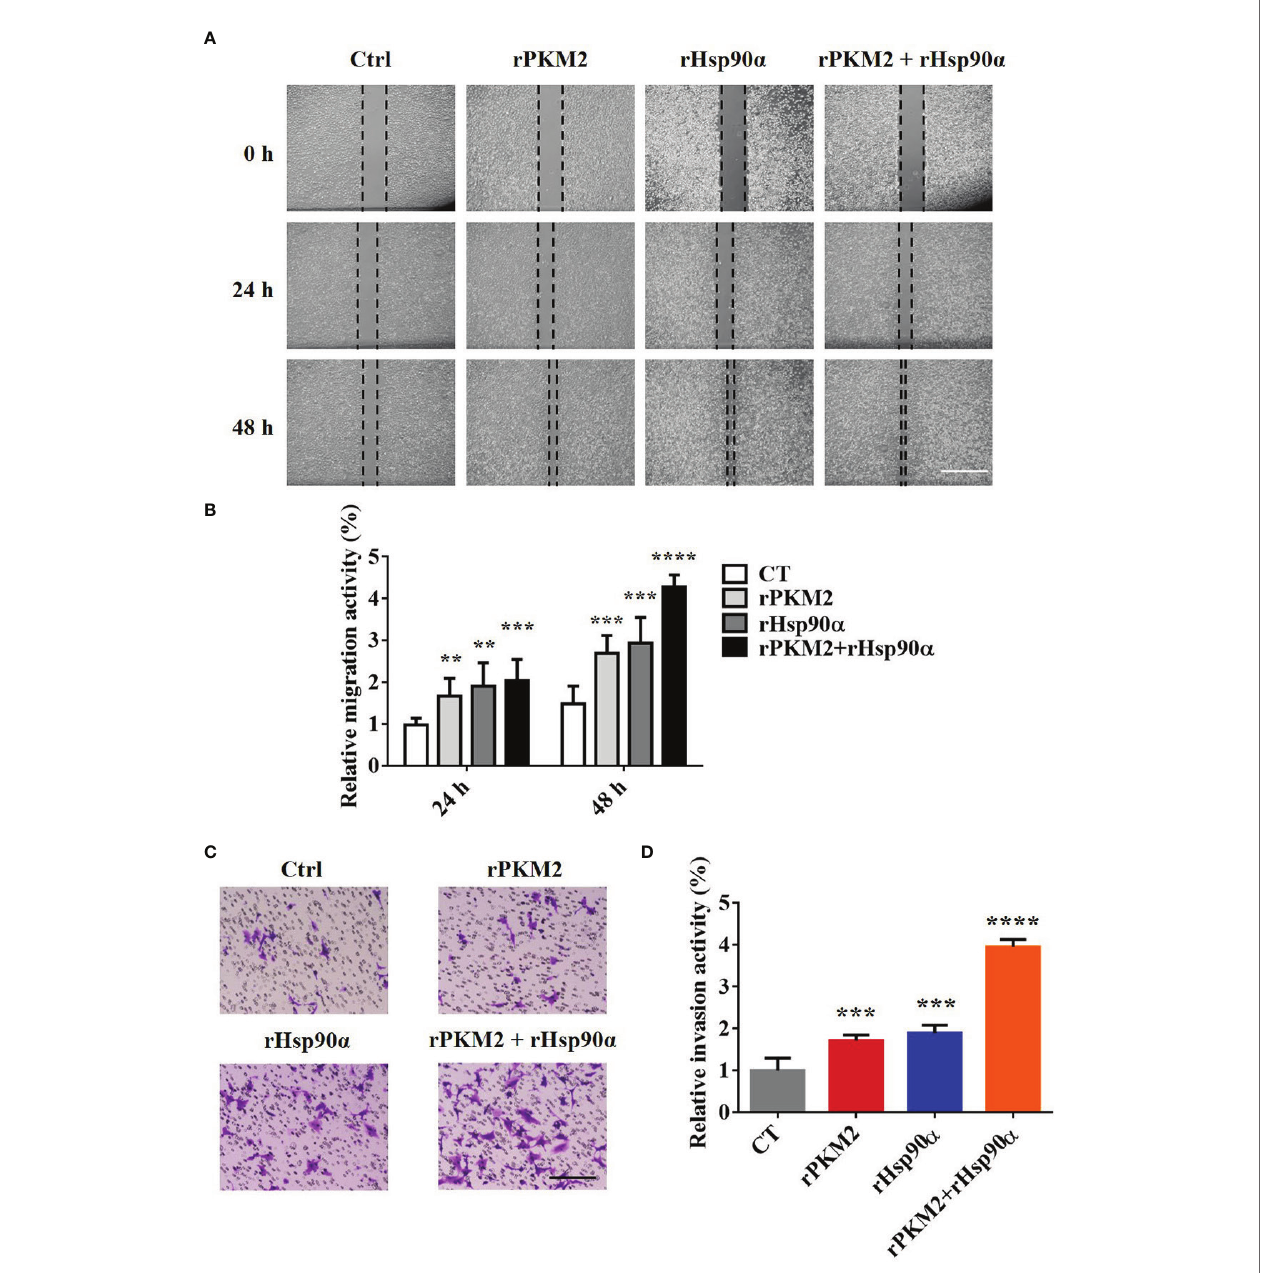
FIGURE 2 | eHsp90 a enhances the promoting effects of ePKM2 on tumor migration and invasion. (A) Representative images of A549 cell migration ability after treatment with rPKM2 (5 m g/ml), rHsp90 a (5 m g/ml), or the combination of rPKM2 and rHsp90 a . Scale bar, 200 m m. (B) Quantitative results of A549 cell migration ability after treatment with rPKM2 (5 m g/ml), rHsp90 a (5 m g/ml), or the combination of rPKM2 and rHsp90 a . (C) Representative images of A549 cell invasion ability after the treatment with rPKM2 (5 m g/ml), rHsp90 a (5 m g/ml), or the combination of rPKM2 and rHsp90 a . Scale bar, 200 m m. (D) Quantitative results of A549 cell invasion ability after the treatment with rPKM2 (5 m g/ml), rHsp90 a (5 m g/ml), or the combination of rPKM2 and rHsp90 a . Data are represented as mean ± SD. NS, not signi fi cant; ** p < 0.01, *** p < 0.001, **** p < 0.0001, two-tailed Student ’ s t tests; n = 3 biological